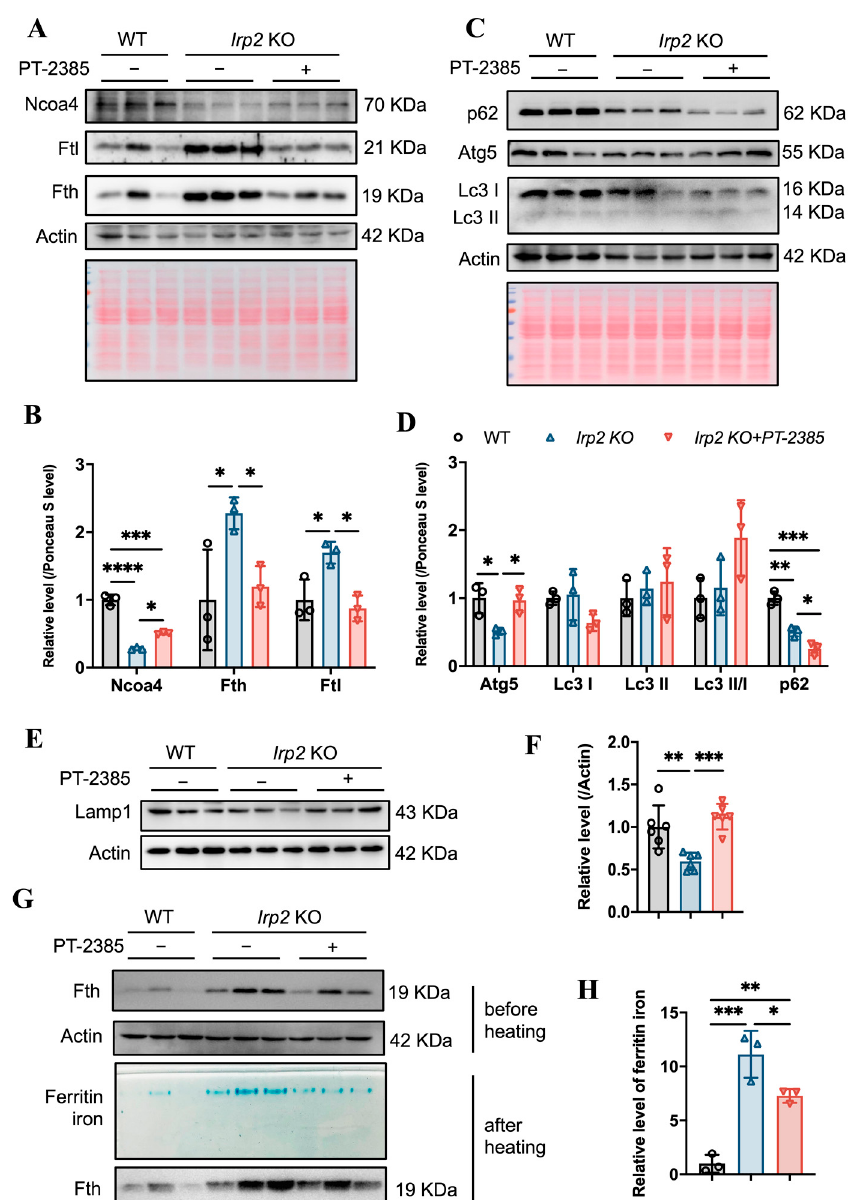
Figure 6. Hif2 inhibition stimulates Ncoa4-mediated ferritinophagy for iron release from ferritin in Irp2 KO liver. ( A ) Expression of Ncoa4 and iron-related proteins (Fth and Ftl) after PT–2385 treatment in liver of Irp2 KO and WT mice. Actin and Ponceau S stain were used as internal controls. ( B ) Quantification of ( A ) to show significance. ( C ) Expression of autophagy-related proteins (Atg5, Lc3, and p62). Actin and Ponceau S stain were used as internal controls. ( D ) Quantification of ( C ) to show significance of Atg5, Lc3, and p62 changes. ( E ) Lamp1 expression. Actin was used as an internal control. ( F ) Quantification of Lamp1 to show significance. ( G , H ) Result of ferritin iron staining in gels. n ≥ 3. Results are shown as mean ± SD. One-way ANOVA was used for significance. * p <